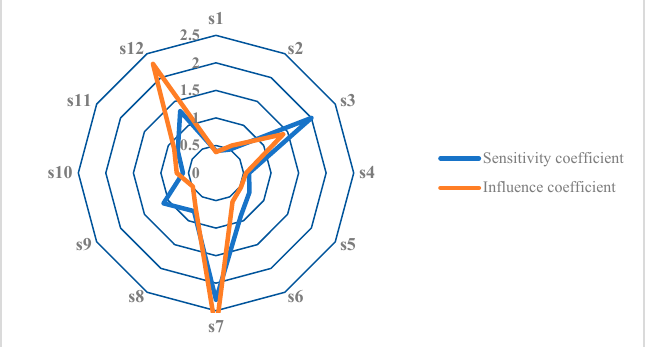
Figure A2. Industrial linkage coefficient(including sensitivity and influence coefficients) of Shenzhen in 2019.